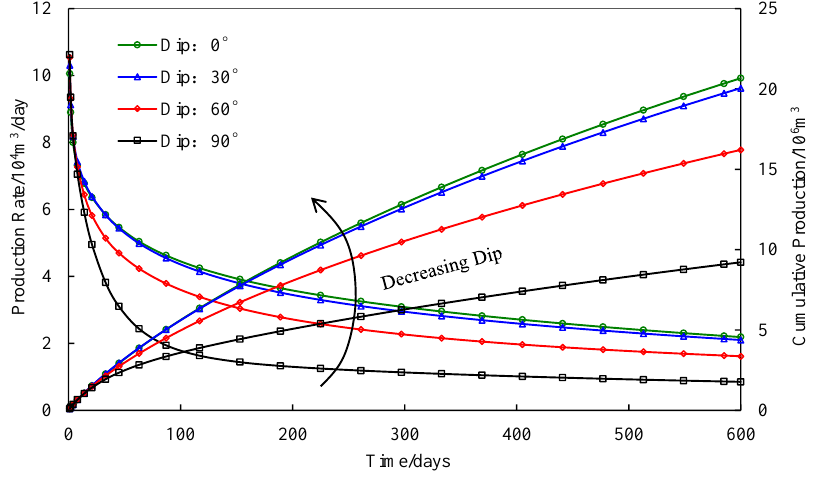
Figure 9. Effect of dip on gas production rate and cumulative production (decline curves represent gas production rate curves, increasing curves represent cumulative production curves).